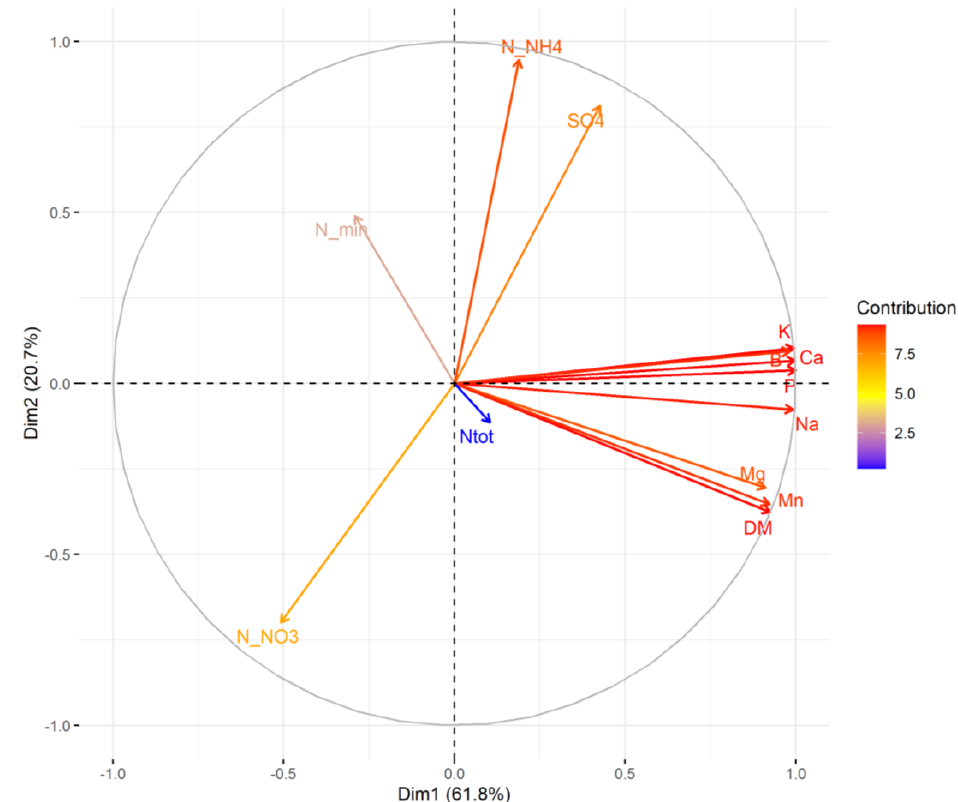
Figure A2. Rohlf’s PCA biplot for properties of digestate treatments.